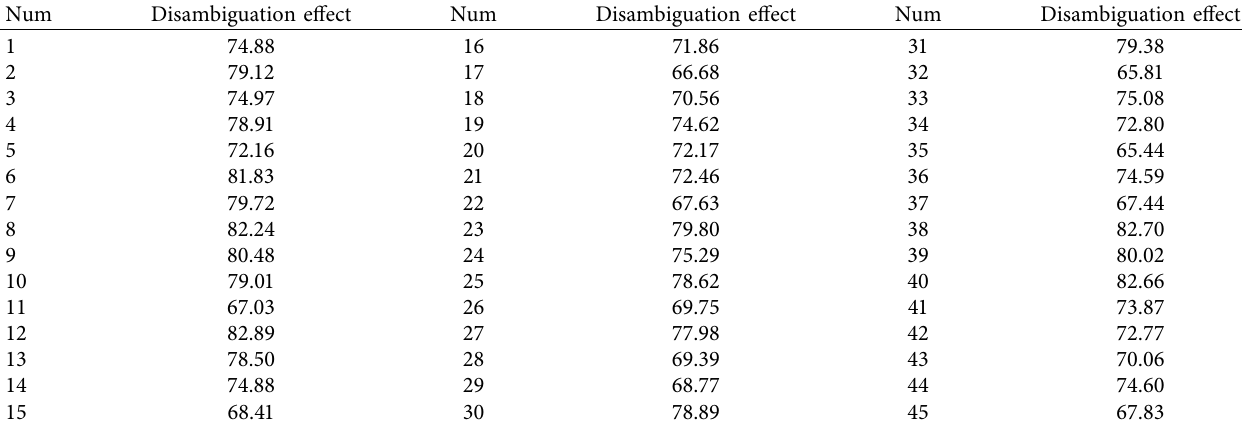
Table 2: Word sense disambiguation